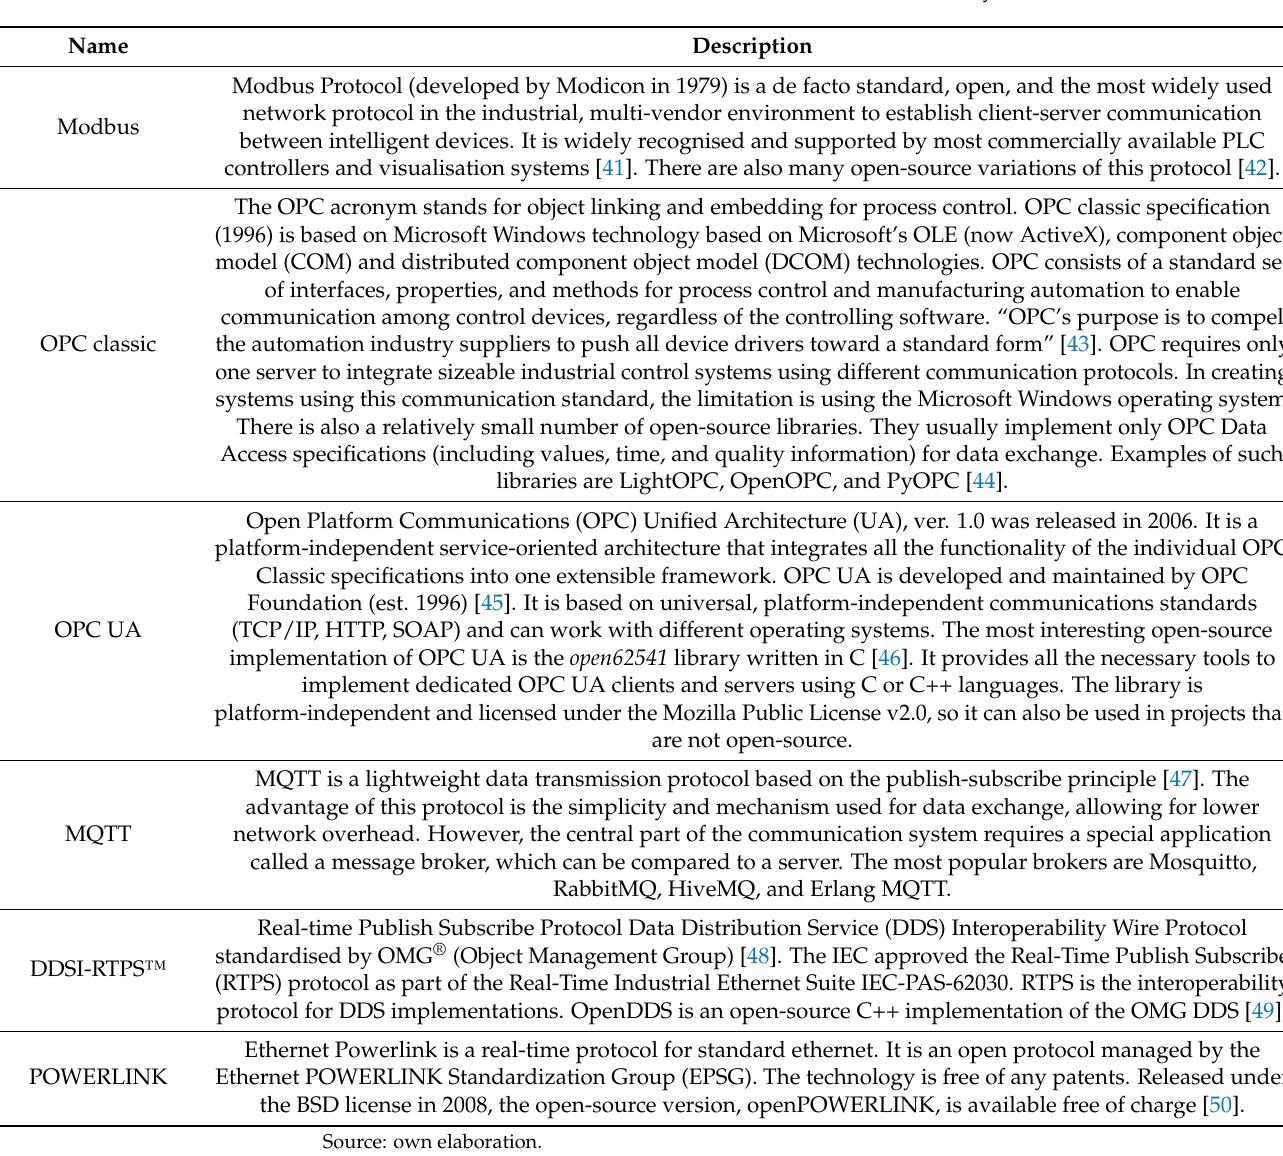
Table 6. Industrial communication standards used in automation